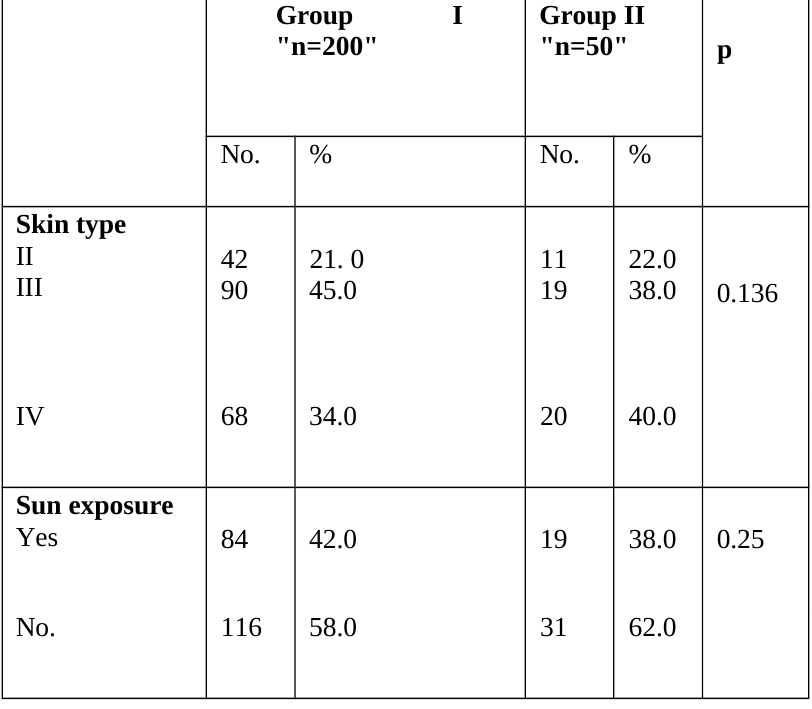
Table (5): Comparison between the two studied groups regarding type of acne Type of acne